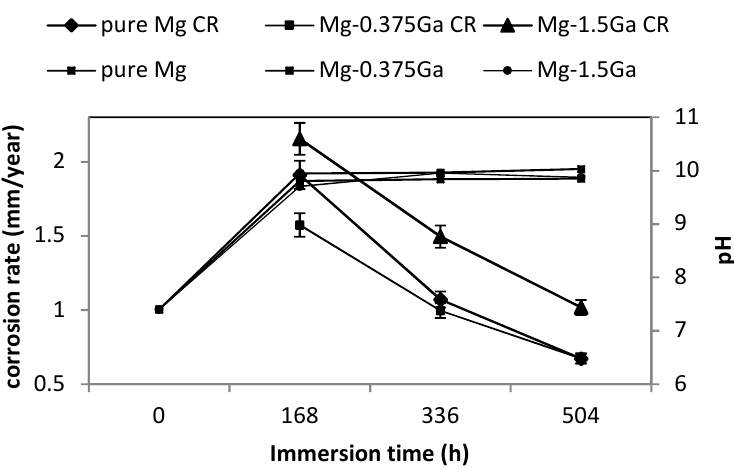
Figure 4. Corrosion rate and pH of the corresponding SBF for pure magnesium, Mg-0.375Ga, and Mg-1.5Ga alloys as a function of immersion time.